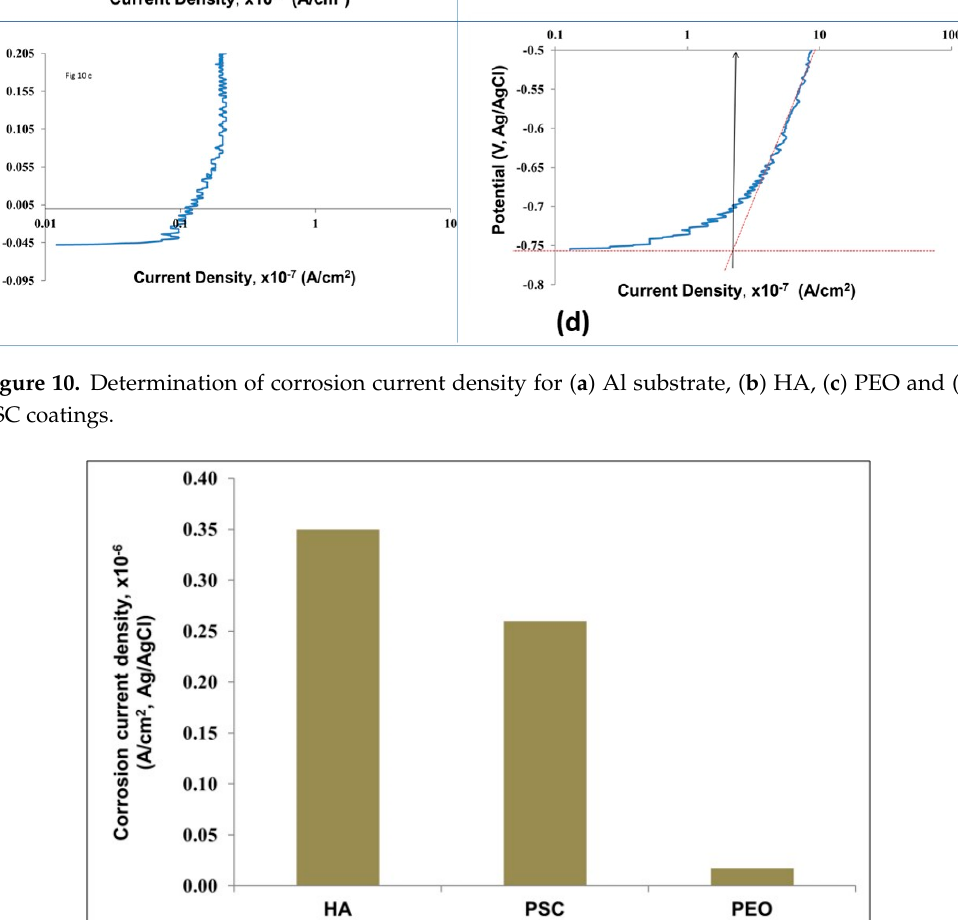
Figure 11. Comparison of corrosion current density values from AP measurements for the coated test specimens.